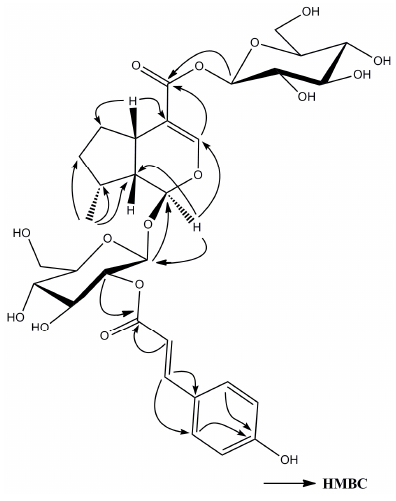
Figure 4. Selected HMBC correlations for compound 5 .